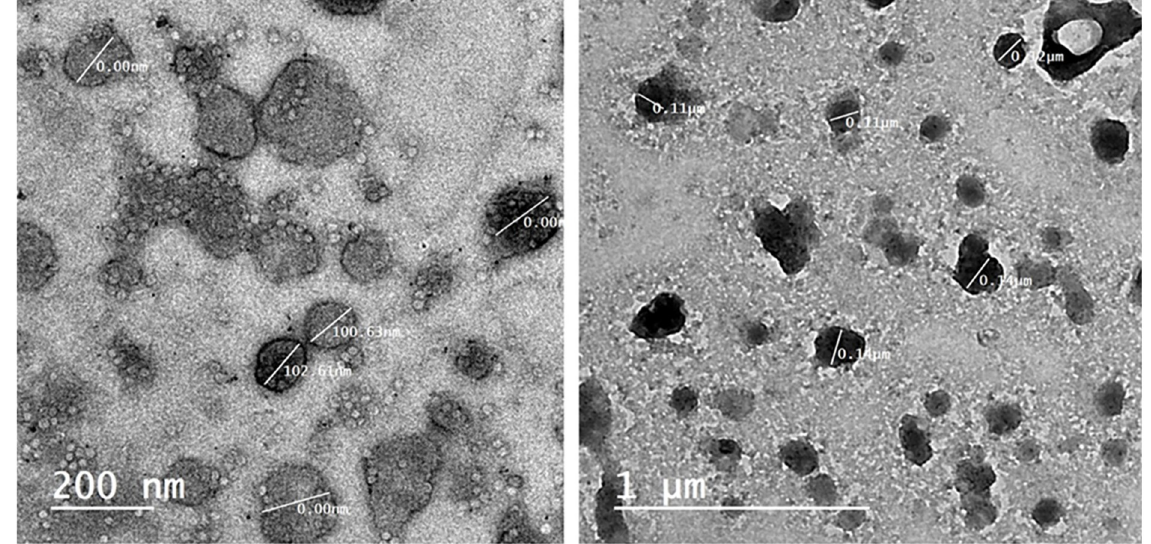
Fig 9. TEM images showing intracellular biologically active T/AgNPs and cellular disruption.